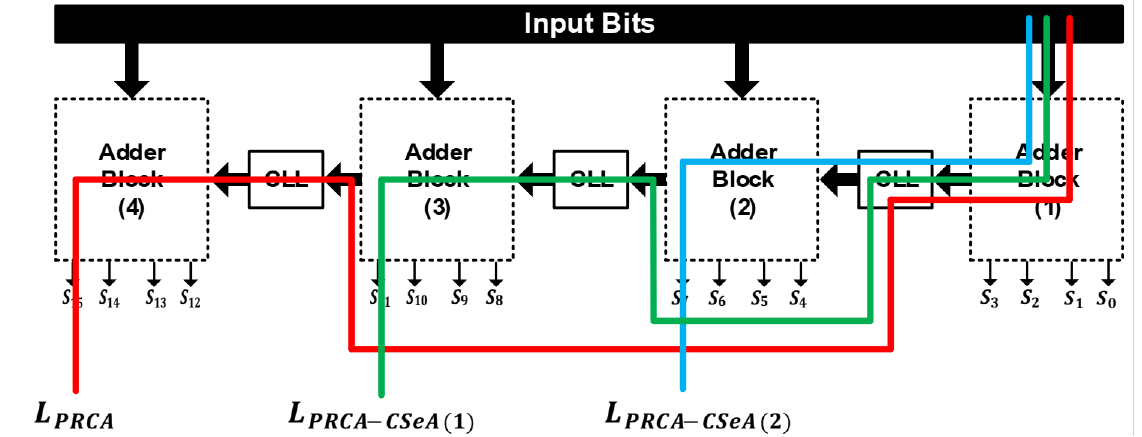
Figure 4. Delay Path for PRCA and PRCA-CSeA